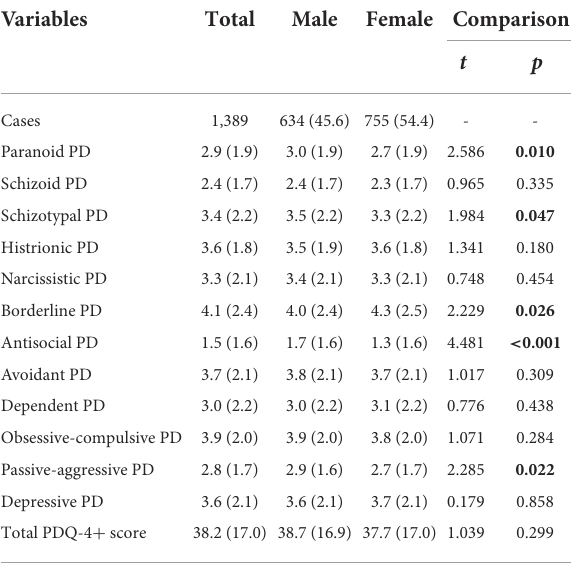
TABLE 2 Self-reported PDs traits using PDQ-4 + compared between male and female outpatients.